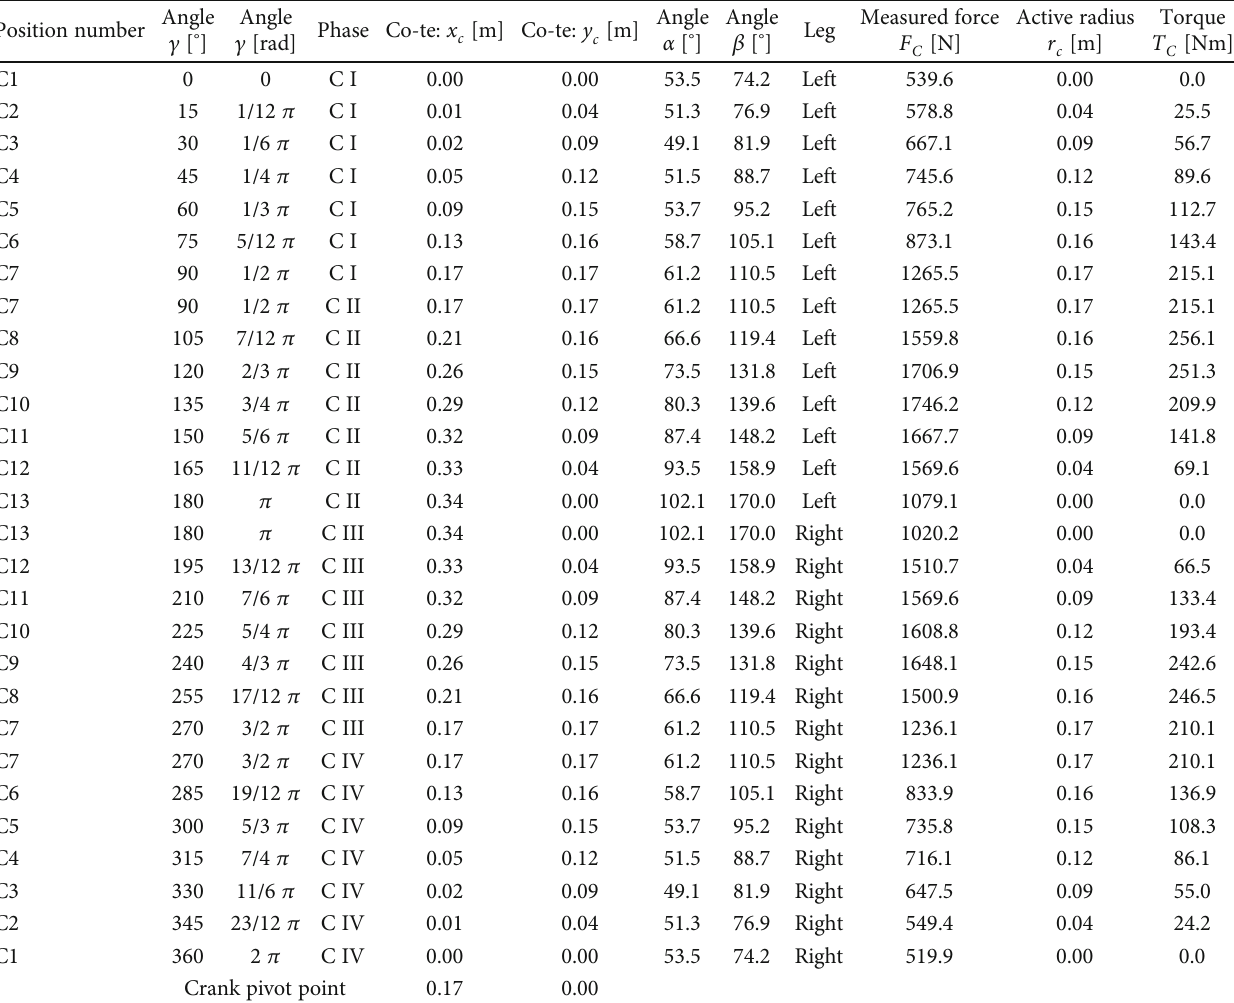
Table 1: Data from analysis and tests for the crankset.